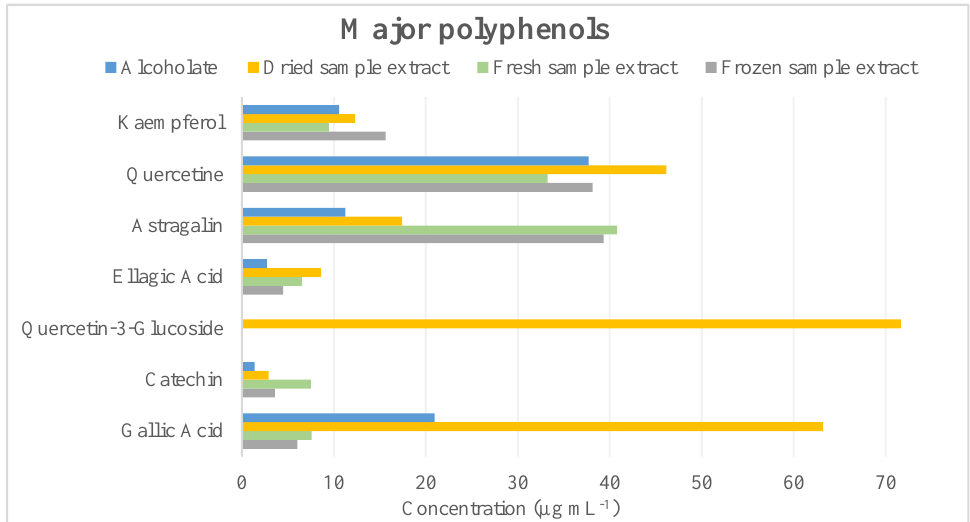
Figure 4 . Major polyphenols found in the Filipendula extracts. Figure 4. Major polyphenols found in the Filipendula